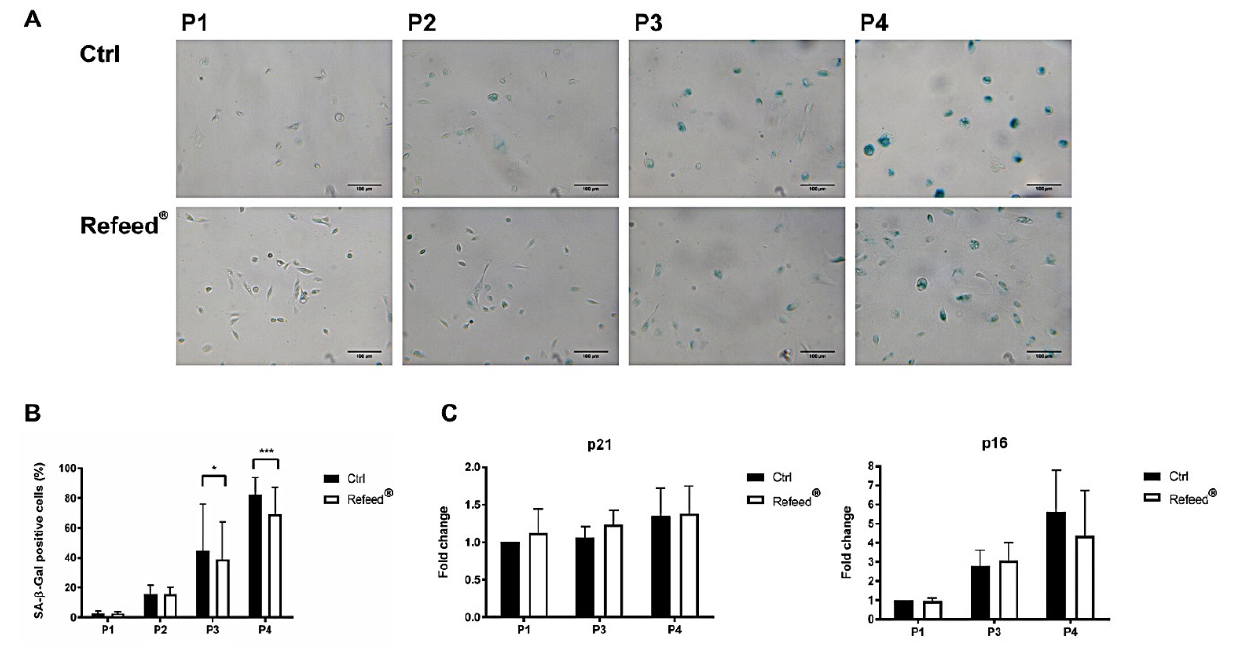
Figure 7. Senescence analysis of human Amniotic Epithelial Cells (hAECs) cultured with and without Refeed ® supplement. ( A ) Representative images of hAECs, cultured from passage 1 to 4 (P1–P4) in basal medium (Ctrl) and with Refeed ® supplement were acquired after SA- β -Gal staining. Images were obtained using the optical microscope Leica Labovert FS inverted Microscope equipped with a Leica MC170 HD digital camera. Scale bars = 100 µ m; ( B ) the percentage of blue-stained SA- β -Gal-positive cells was calculated during in vitro cell culture. Results are represented as mean ± standard deviation (SD), (* p < 0.05, *** p < 0.001); ( C ) gene expression analysis of p16 and p21 in hAECs cultured without (Ctrl) or with Refeed ® at P1, P3, and P4. Data were normalized to two reference genes, TBP (TATA box binding protein) and glyceraldehyde-3-phosphate dehydrogenase (GAPDH); the normalized expression value of untreated hAECs at P1 was set to 1, and the other gene expression data were reported to that sample. Data are expressed as fold change ± SD. The experiment was performed on three human samples in technical triplicate.